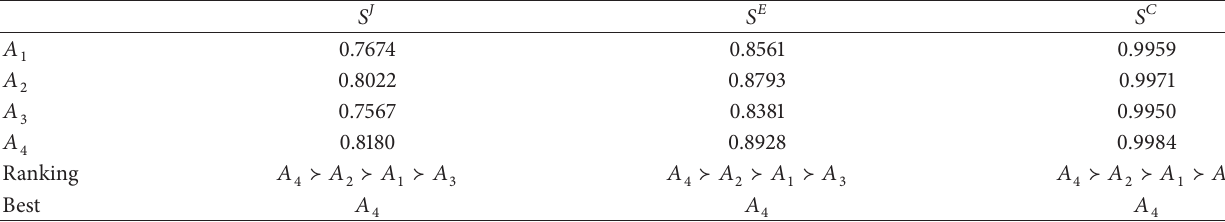
Table 4: Decision results for different weights in the same numerical